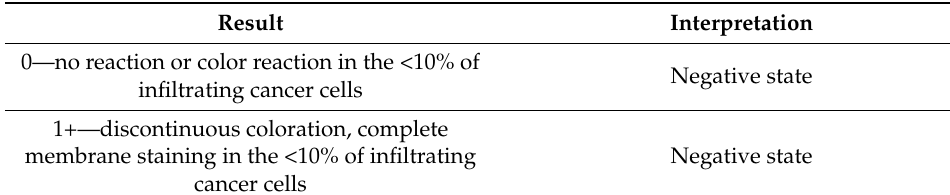
Table 5. HER-2 receptor IHC rating scale,